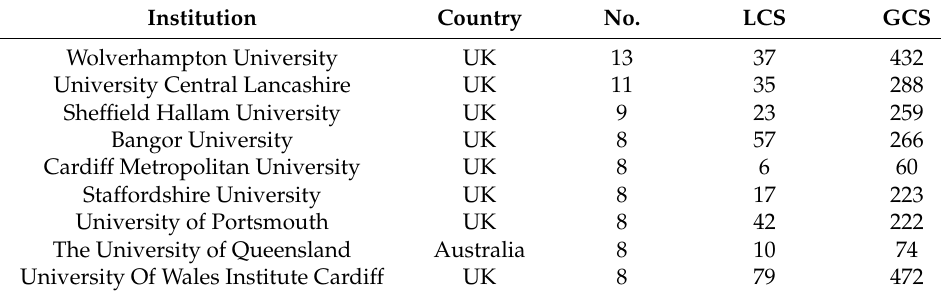
Table 3. Number of publications by